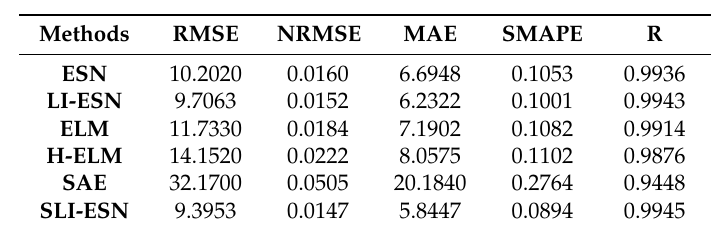
Table 2. Comparison of one-step (1 hour) prediction results. Abbreviations: root mean square error